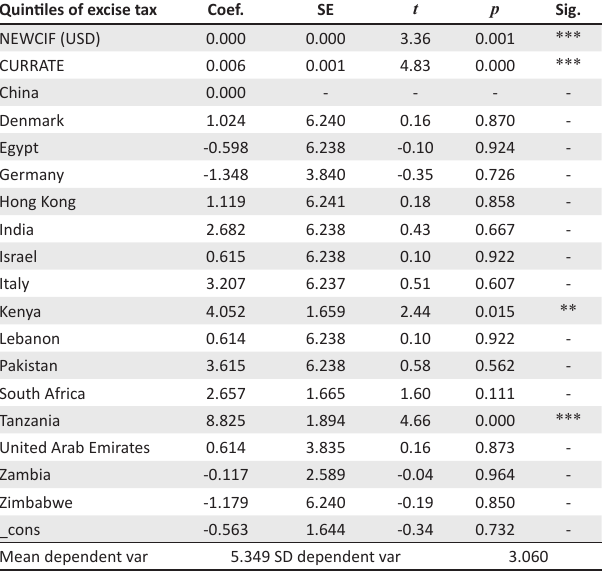
TABLE 4: Excise tax quintiles and origin of cigarette imports regression results. Quintiles of excise tax Coef. SE t p Sig. NEWCIF (USD) 0.000 CURRATE China 0.000 - Denmark 1.024